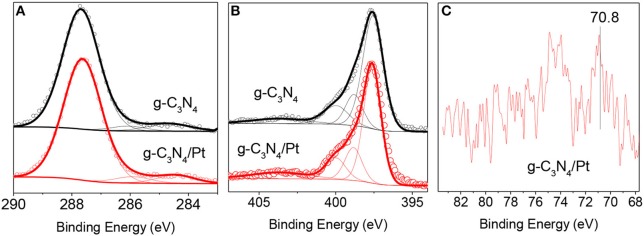
High-resolution XPS spectra of (A) C1s, (B) N1s, and (C) Pt4f in g-C3N4/Pt sample and g-C3N4 reference.